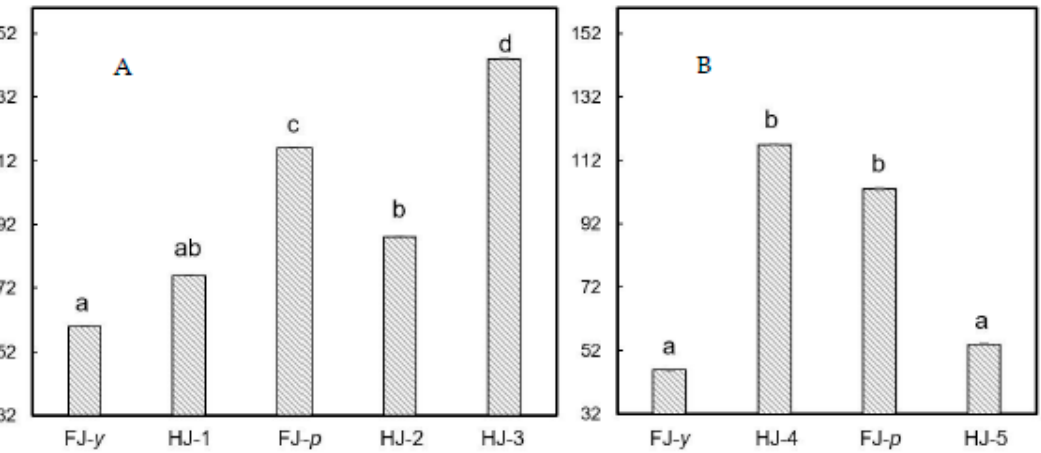
Figure 4. Ranking tests for bitterness: ( A ) among samples FJ -p , FJ -y , HJ-1, HJ-2, HJ-3; and ( B ) among samples FJ -p , FJ -y , HJ-4, HJ-5. Different letters indicate significant differences.